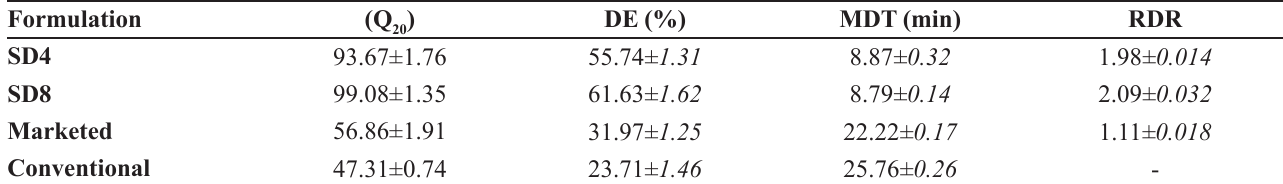
TABLE VII - Dissolution parameters of FPN from SD4, SD8, marketed and conventional tablets (Mean ± SD, n=3)